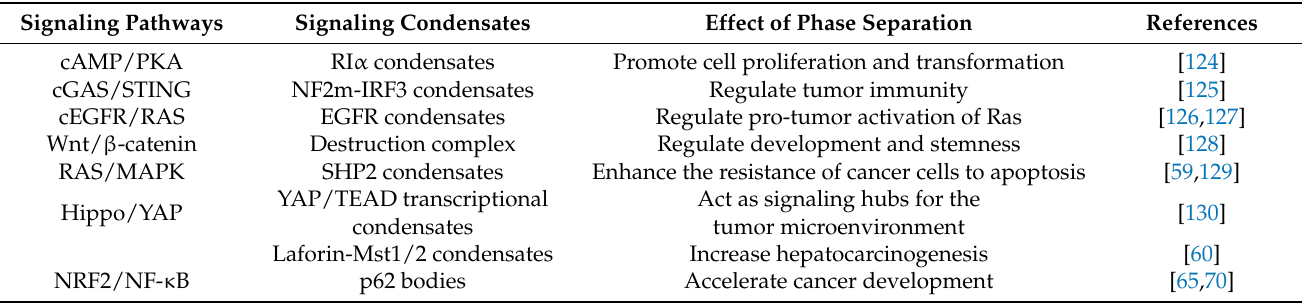
Table 2. Abnormal biomolecular condensates in signaling pathways.